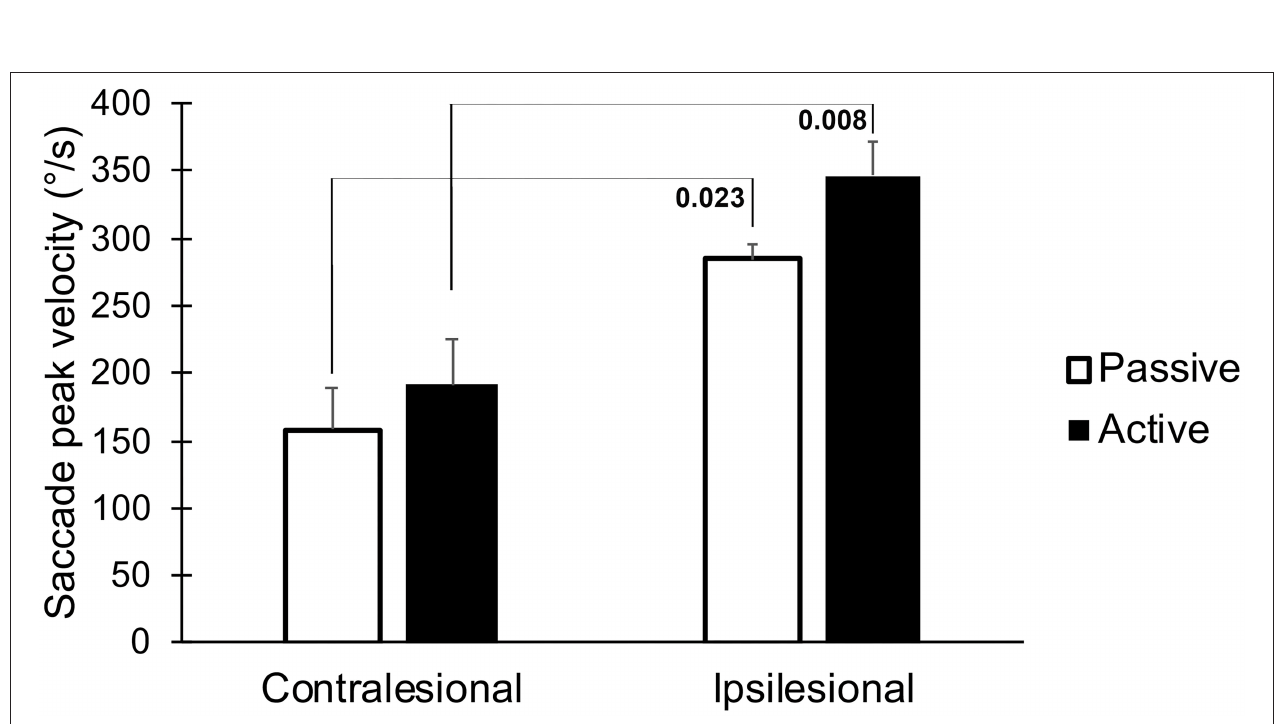
FIGURE 5 | The peak velocity of the first saccade, when performing head thrusts in the ipsilesional and contralesional directions with active and passive head movements. Bars representing mean values for the group. Error bars indicate SEM. Bonferroni corrected post- hoc statistics presented numerically.